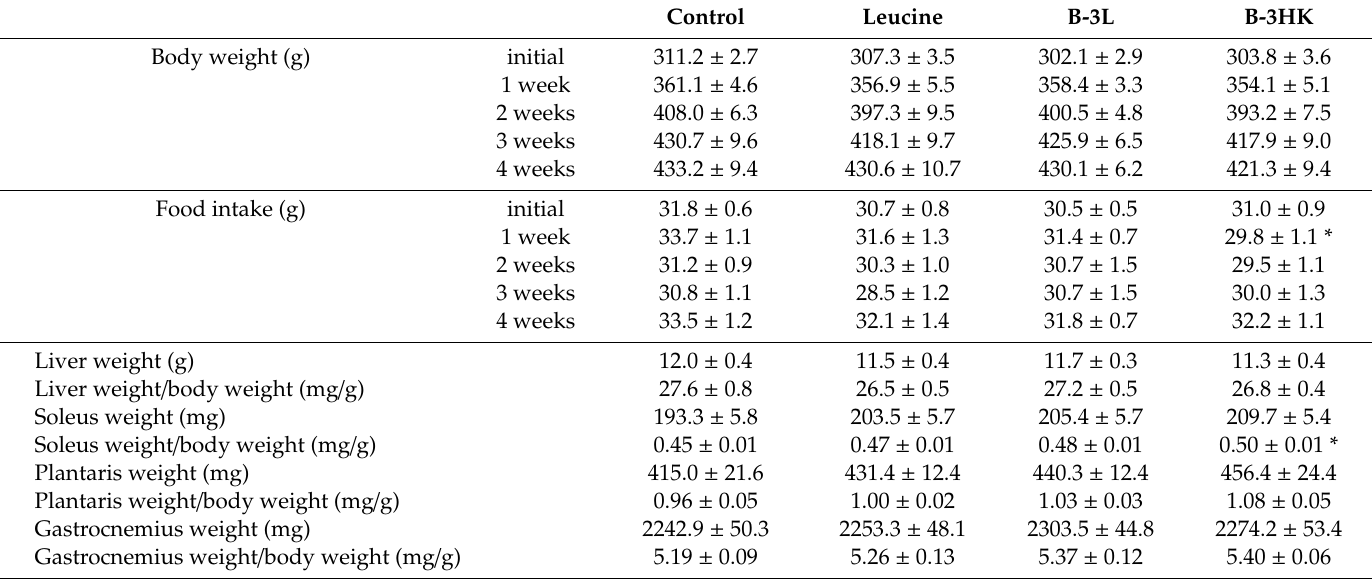
Table 1. The e ff ects of B-3 on body and tissue weights in